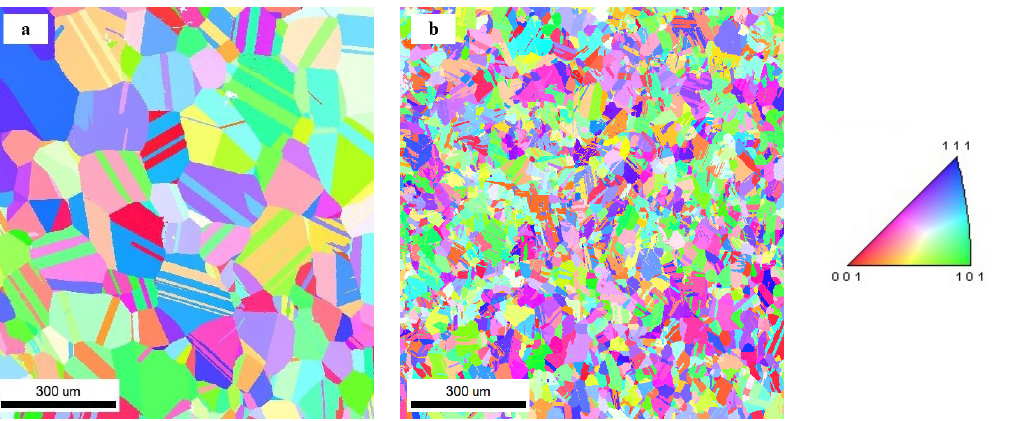
Figure 3. Inverse pole figure (IPF) map for: ( a ) IN 617 AR sample; ( b ) IN 617 GBE